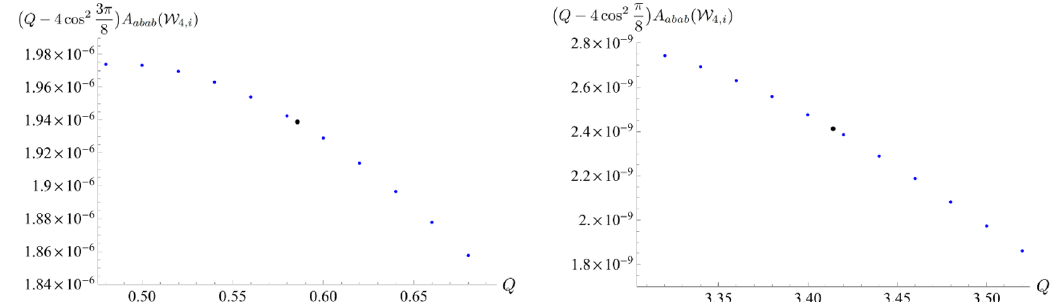
(cid:0) 3 π (cid:1) (cid:0) π (cid:1) (left) and Q = 4 cos 2 8 8